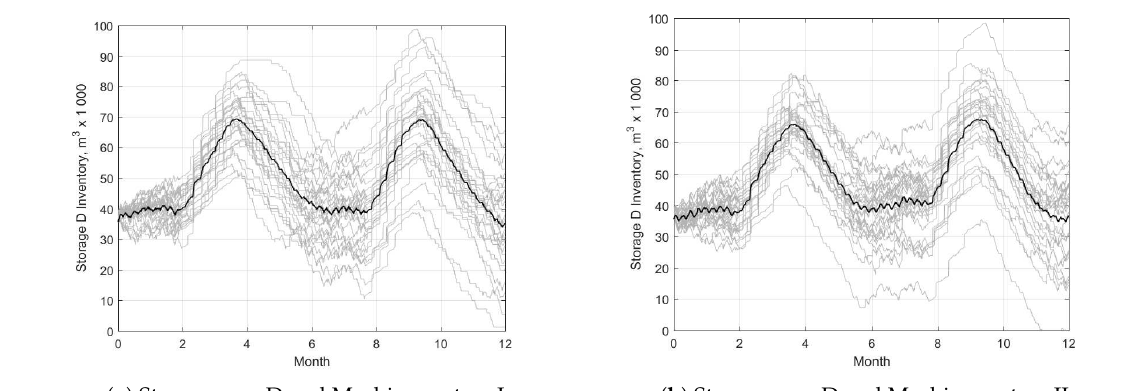
Figure 6. Average of 30 yearly simulation results (black line) and individual results of 30 yearly simulations (grey lines) showing inventory level fluctuation at storage areas A, B, C, and D under Strategy III using Machine Systems I (left side) and II (right side) (S3 M1 and